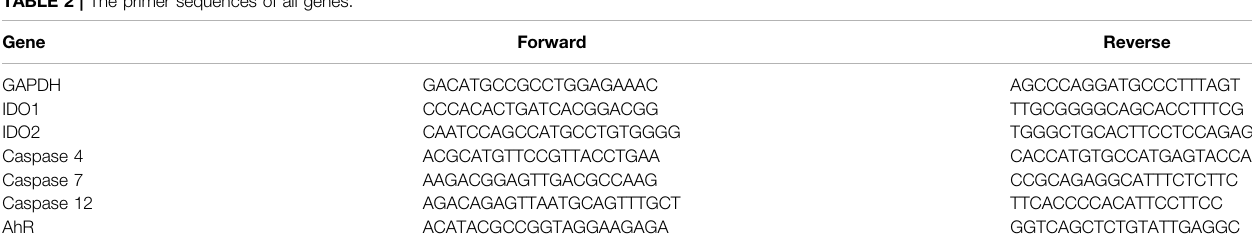
TABLE 2 | The primer sequences of all genes. Gene Forward Reverse GAPDH